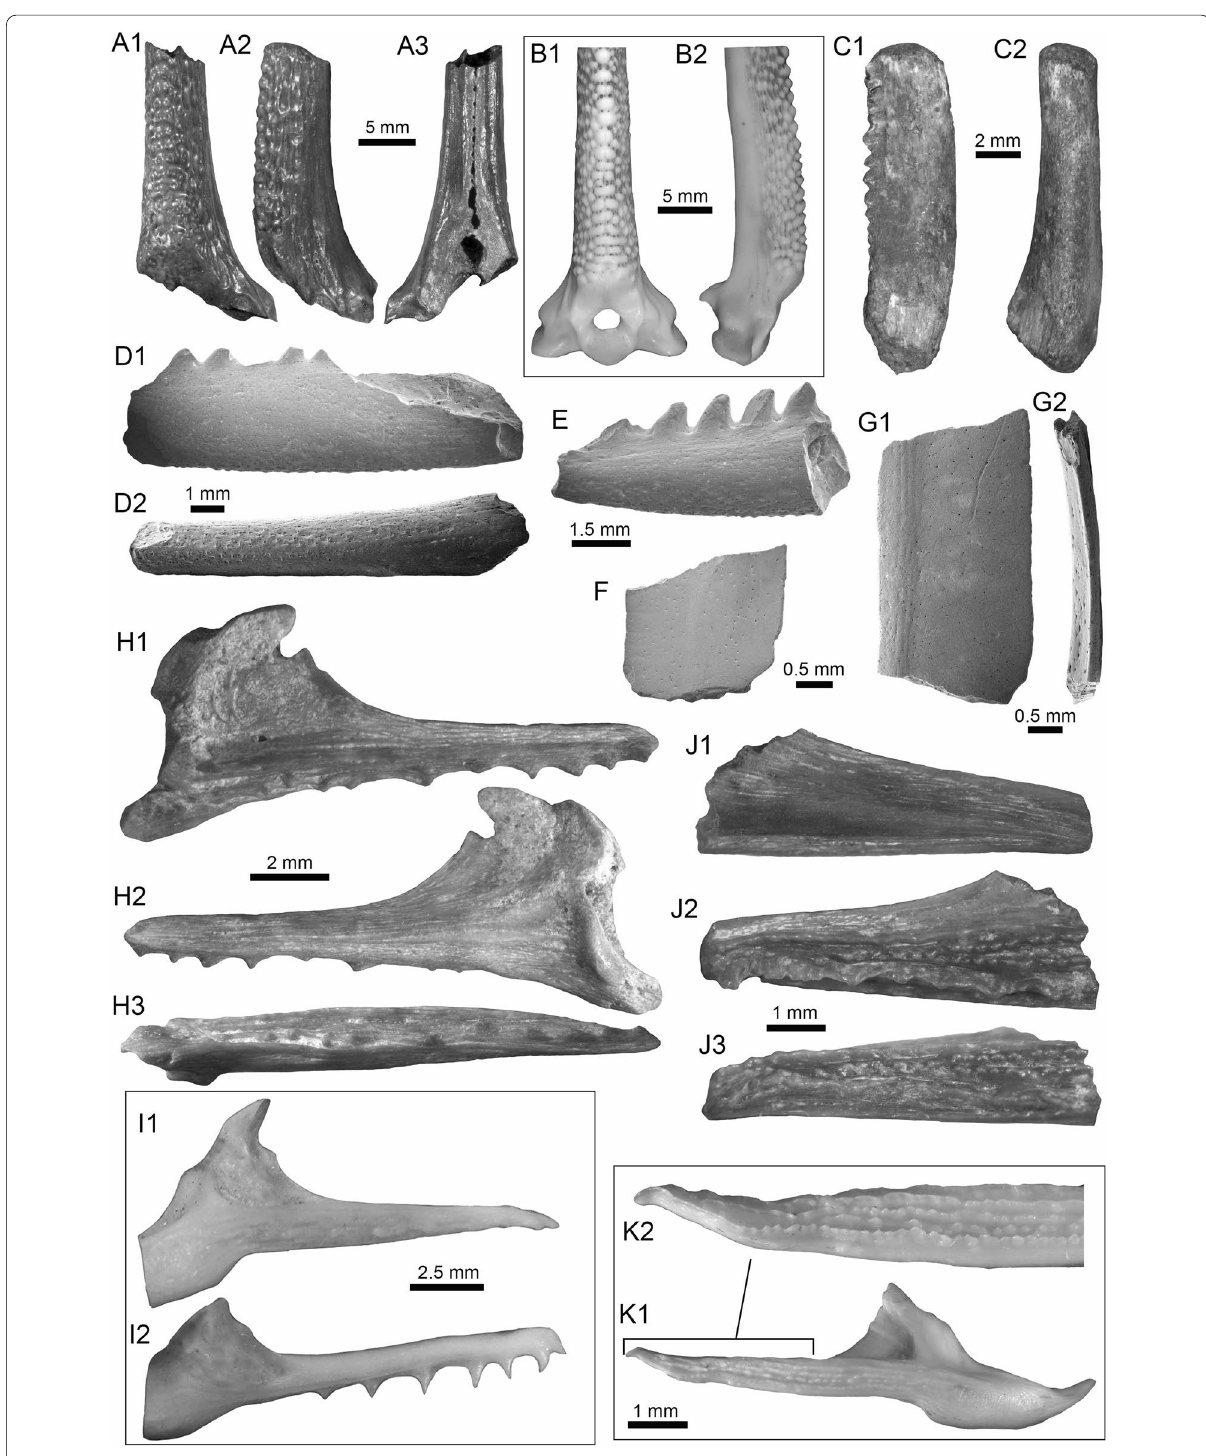
Fig. 8 Siluriformes (Ariidae, Callichthyidae, and Doradidae) from the Vergel Member. A1 – A3 Dorsal spine of cf. Sciades sp. (AMU‑CURS‑1058). B1 , B2 Recent dorsal spine of Sciades proops (PIMUZ A/I 4874). C1 – E Pectoral‑fin spines and F – G2 bony plate fragments of Callichthyidae indet. ( C1 , C2 left spine, AMU‑CURS‑1167a; D1 – E AMU‑CURS‑1168 and F – G2 AMU‑CURS‑1169). H1 – H3 Partial left cleithrum cf. Amblydoras sp. (AMU‑CURS‑1225). I1 , I2 Recent left cleithrum of Amblydoras affinis (CAS 66236). J1 – J3 Partial right cleithrum of cf. Scorpiodoras sp. (AMU‑CURS‑1226). K1 , K2 Recent left cleithrum of Scorpiodoras heckelii (MHNLS‑17959). Views: anterior ( A1 , B1 , C2 , D2 ), dorsal ( C1 , I2 ), dorsolateral ( H1 , J2 ), lateral ( A2 , B2 , F – G1 , H3 , J3 , K1 , K2 ), mesial ( J1 ), posterior ( A3 ), ventral ( H2 ), and indet. ( D1 , E , G2